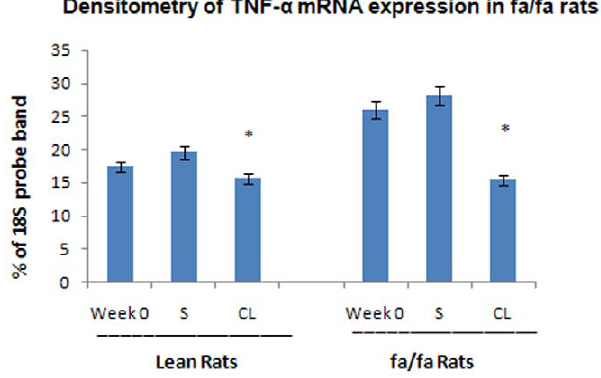
Figure 7. Densitometry of the TNF- a mRNA bands as compared to 18S bands in the same lane. All values are means 6 SEM. There are significant differences as follow: CL- fa/fa vs S- fa/fa , P , 0.001 . CL- fa/fa vs S-lean, P , 0.05 . CL-lean vs S-lean and lean week 0, is not significant. There is nosignificant difference between CL- fa/fa and CL-lean rats at 4 weeks after